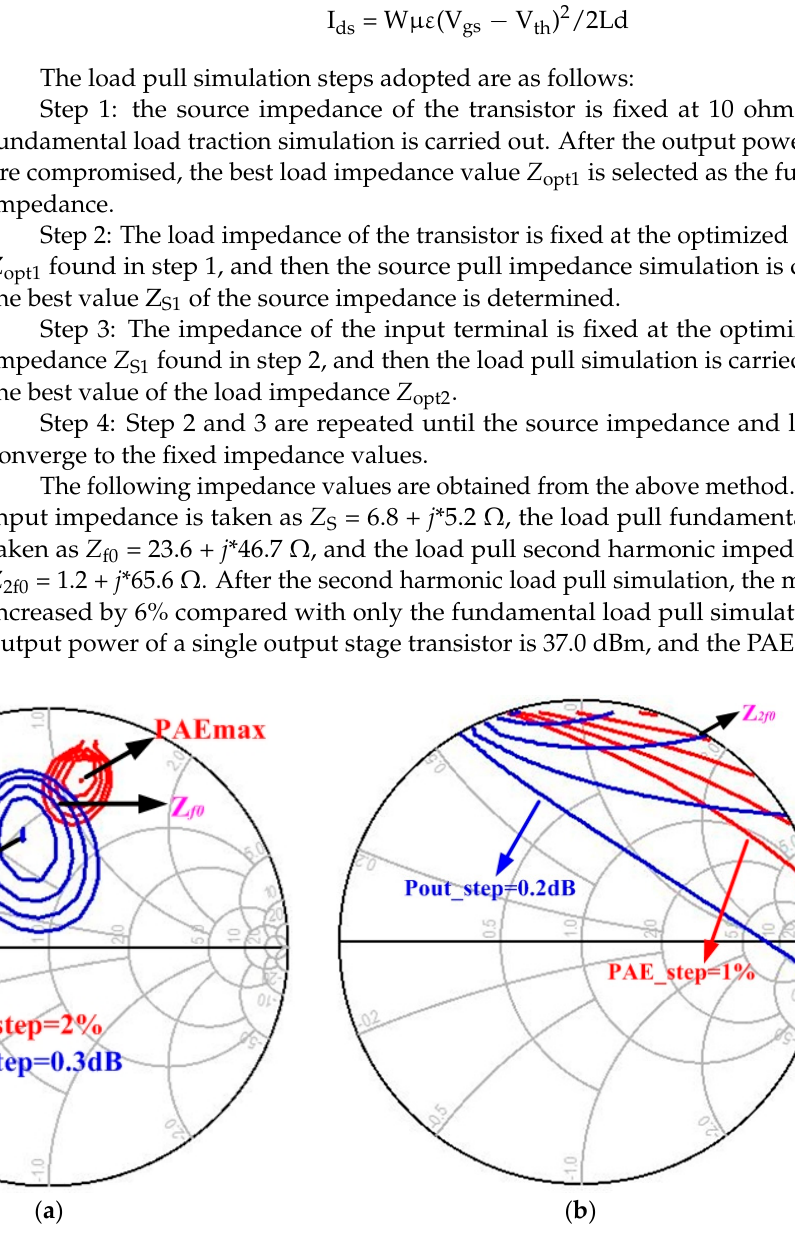
Figure 2. The fundamental and second harmonic impedance load pull simulation of the 6 × 150 μ m transistor: ( a ) Fundamental impedance load pull simulation; ( b ) Second harmonic impedance load pull simulation.